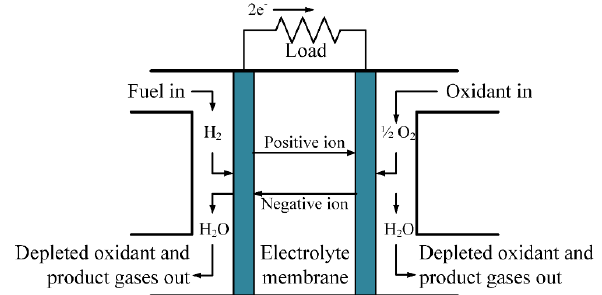
Figure 63. Fuel cell operation diagram; hydrogen and oxygen are present at the anode and cathode respectively, and water is produced as by-product [190]. respectively, and water is produced as by-product